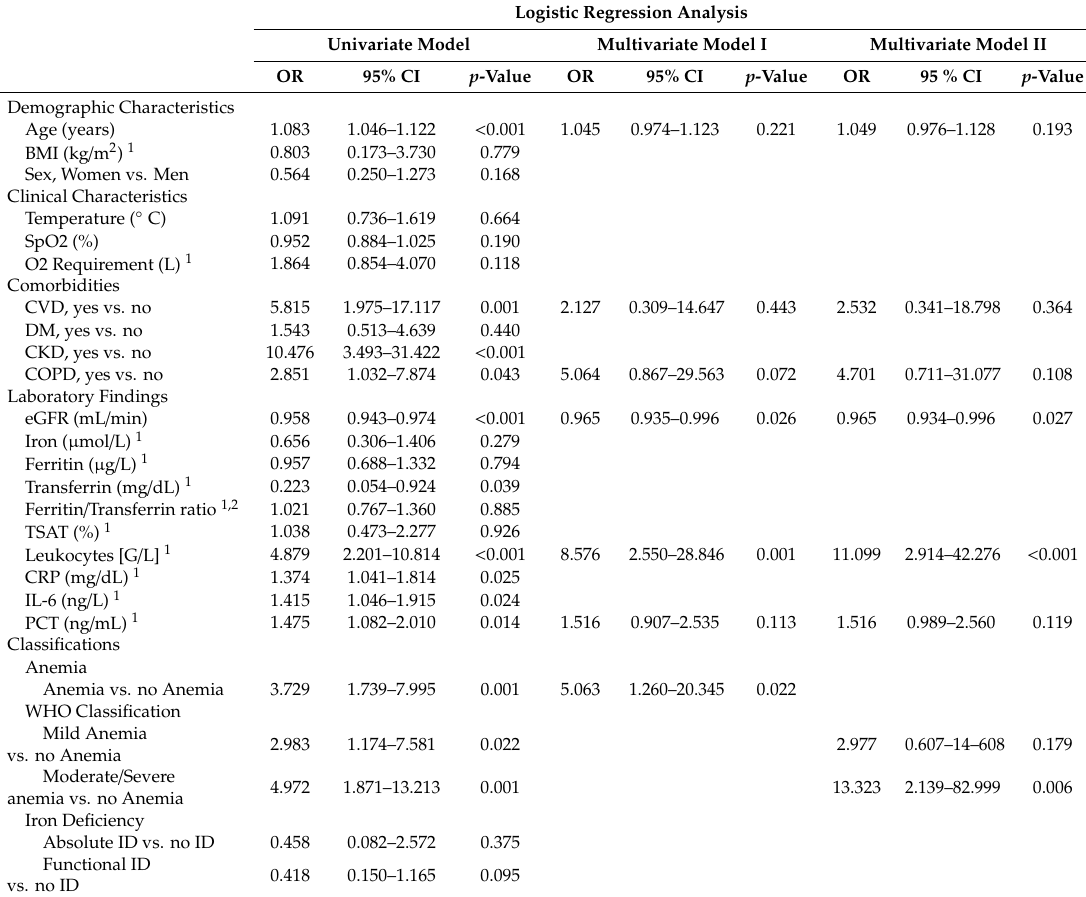
Table 2. Logistic Regression Analysis in terms of death during hospitalization (yes / no).